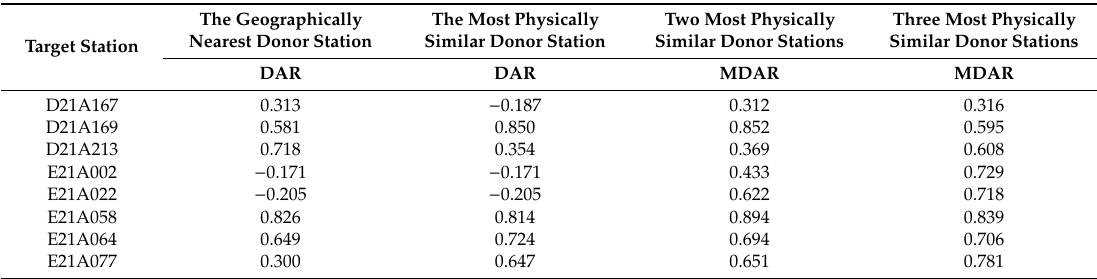
Table 7. NSE values for the drainage area ratio (DAR) and multiple-donor stations drainage area ratio (MDAR) methods in the Middle Euphrates Basin.